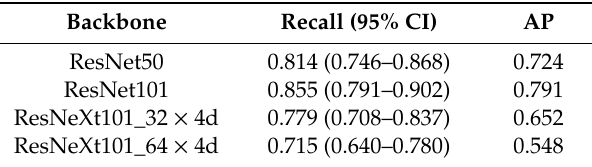
Table 5. Results of di ff erent backbones.